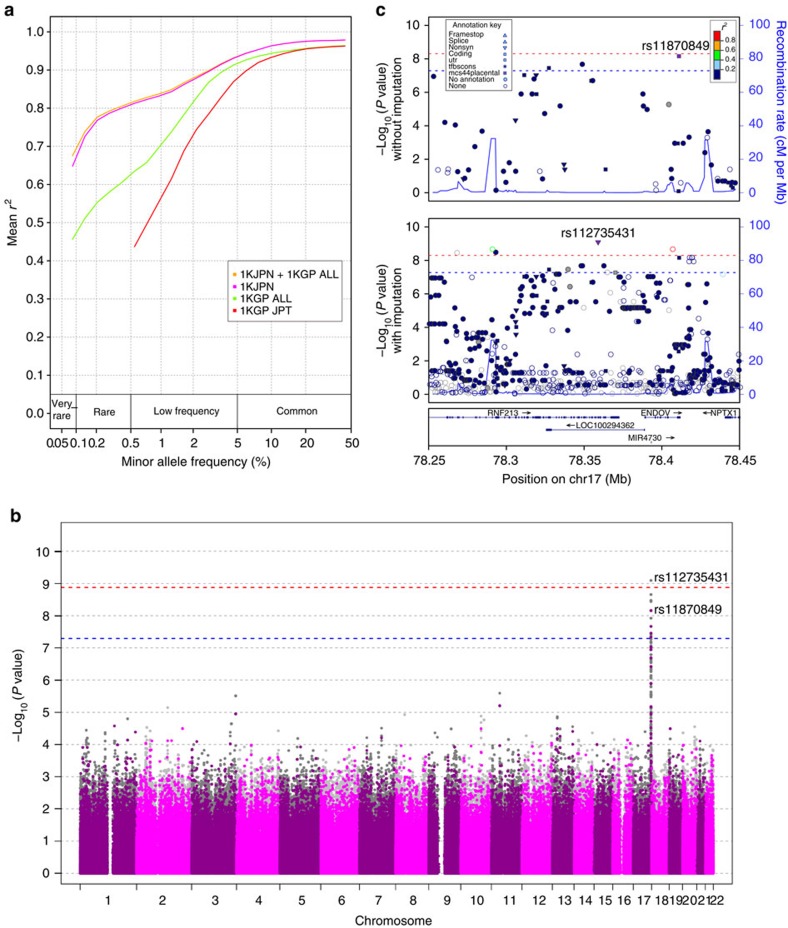
Imputation with the Japanese reference panel.(a) Comparison of imputation performance (r2) for four reference panels: 1,070 individuals in 1KJPN (1KJPN), 1,092 cosmopolitan samples in 1KGP (1KGP ALL), 1KJPN plus 1KGP ALL (1KJPN+1KGP ALL) and 89 Japanese individuals in 1KGP (1KGP JPT). The x axis represents the MAF of each panel. The y axis represents the averaged r2 at SNV sites that exist in both the cosmopolitan samples of 1KGP and 1KJPN. (b) A Manhattan plot of P values from GWAS of MMD. The SNV sites from the original data set and imputed markers are plotted as dots in magenta and grey, respectively. Blue and red lines display the significance threshold of the original and imputed results, respectively. Only one significant signal was identified on chromosome 17. (c) A plot of P values from GWAS of MMD with the original (non-imputed; upper panel) and imputed (lower panel) data set around the SNP exhibiting the significant signal in b. In the imputed result, the SNP with the highest association is a nonsynonymous variant of RNF213, and was reported as one of the MMD-causing variants in the original study. In contrast, from the non-imputed result the SNP with the highest association is located in the coding region of ENDOV.